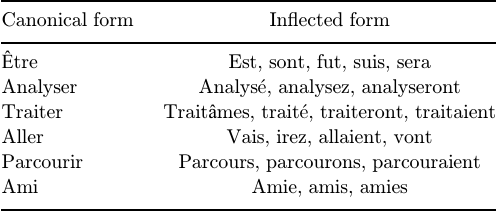
Table 1. Extract from the list of stopwords. Stopwords Le, la, les De, dans, des Avec, ainsi, pour Au-dessus, au-dessous, au Mais, par contre, cependant Telle, cela, certain